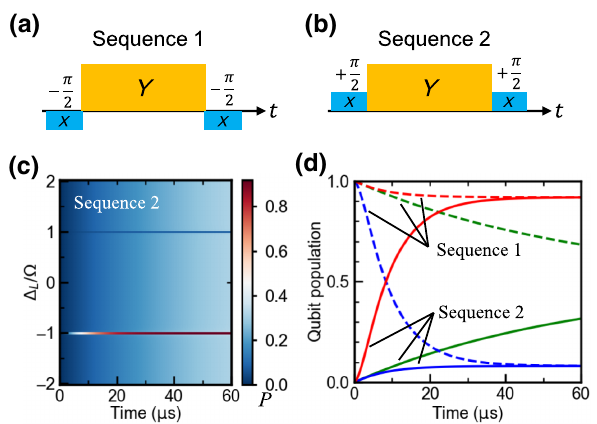
FIG. 9. (a) Schematic of the standard spin-locking sequence used in measurements reported in the main text (sequence 1). (b) Schematic of the modified spin-locking sequence (sequence 2). (c) Results of numerical simulations of the system evolution when the qubit is driven by sequence 2. The population of the qubit state | i +(cid:7) is shown. The initial qubit state is | i −(cid:7) . The other parameters are the same as those used in Figs. 1(c) and 1(d). (d) Comparison of the qubit response at qubit-defect detun- ings (cid:11) L = (cid:10) (blue lines), (cid:11) L = − (cid:10) (red lines), and (cid:11) L (cid:8)= ± (cid:10) (green lines). Solid lines correspond to sequence 2 and dashed lines correspond to sequence 1.